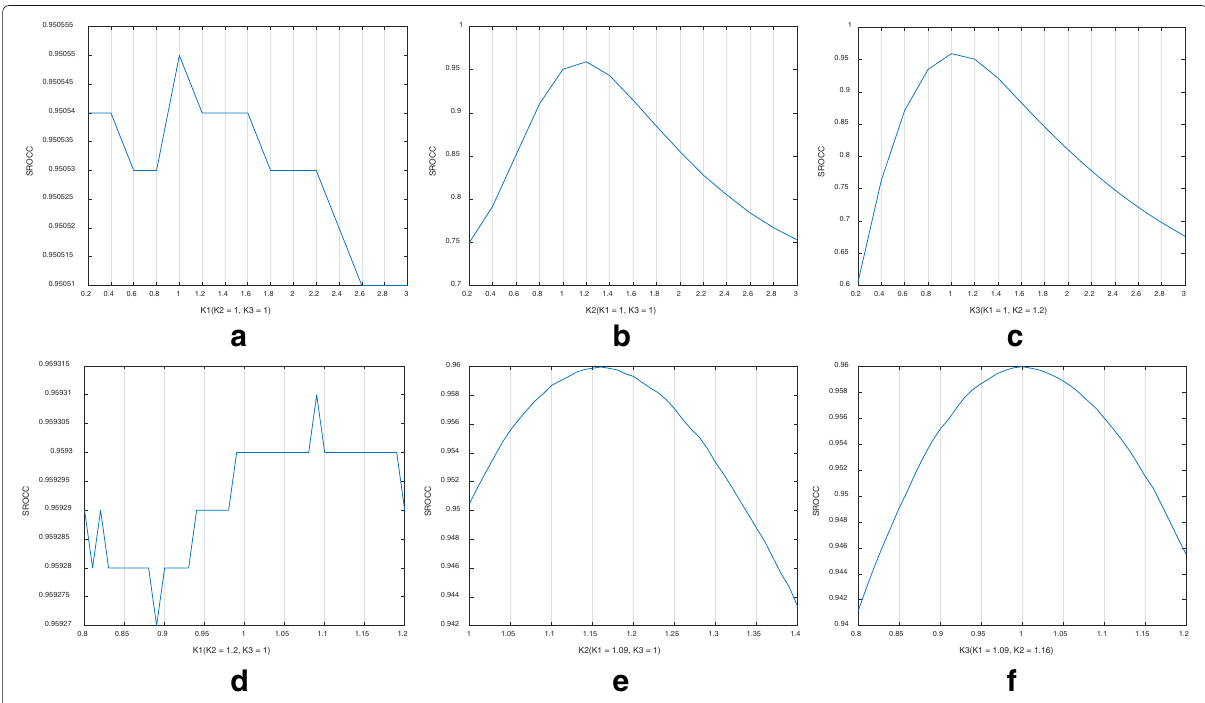
Fig. 6 Determine the optimal values of K 1 , K 2 , and K 3 . a K 2 = 1.0 and K 3 = 1.0, b K 1 = 1.0 and K 3 = 1.0, c K 1 = 1.0 and K 2 = 1.2, d K 2 = 1.2 and K 3 = 1.0, e K 1 = 1.09 and K 3 = 1.0, and f K 1 = 1.09 and K 2 =